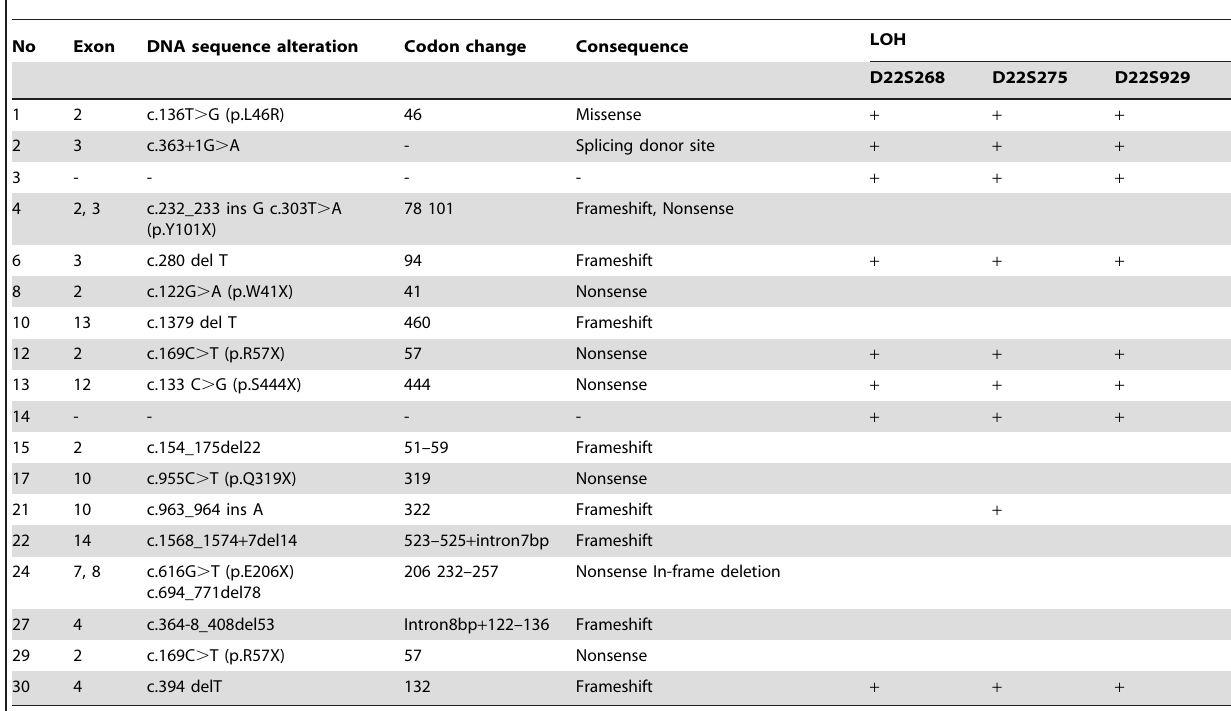
Table 1. Loss of heterozygosity (LOH) and mutation in sporadic vestibular schwannomas.